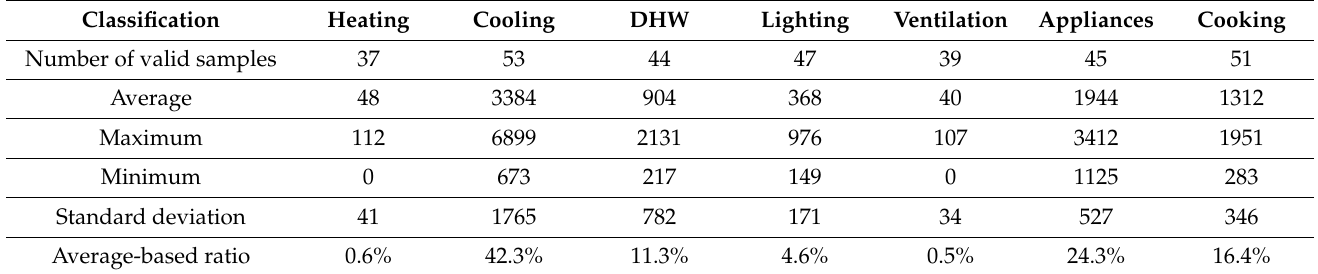
Table 5. Annual statistical data of residential end-use energy consumption (kWh/y).